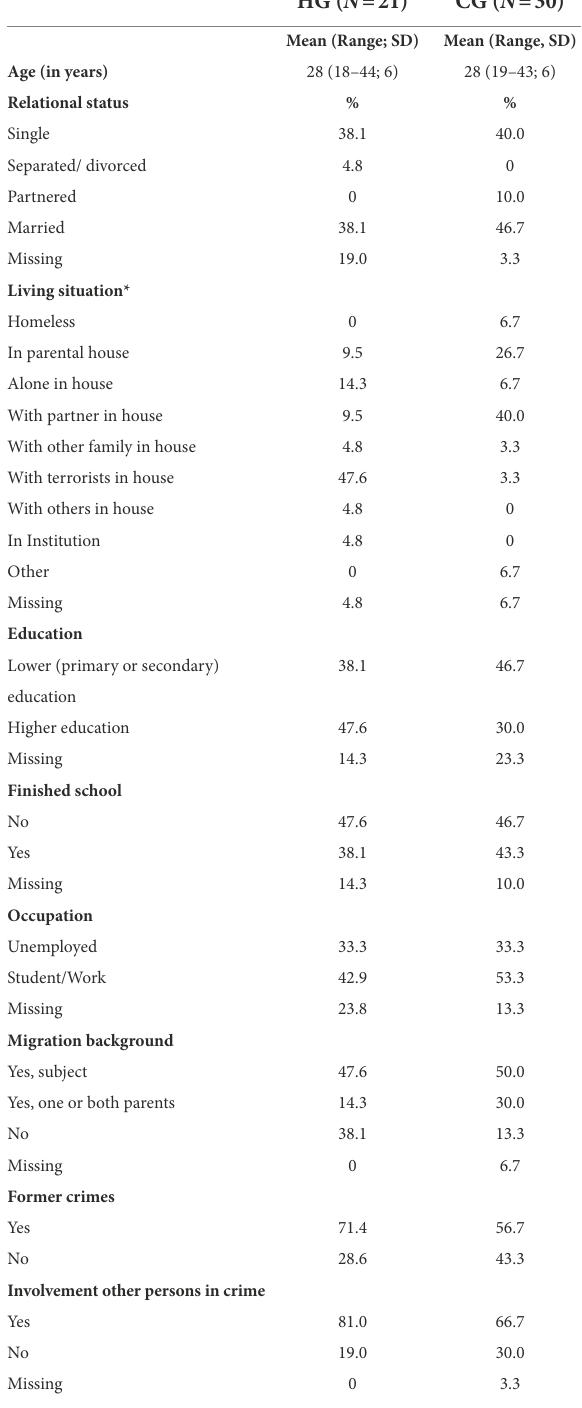
TABLE 2 Demographics, criminal history and type of terrorist crime in male Jihadist homicide offenders (HG) and male Jihadist non- homicide offenders